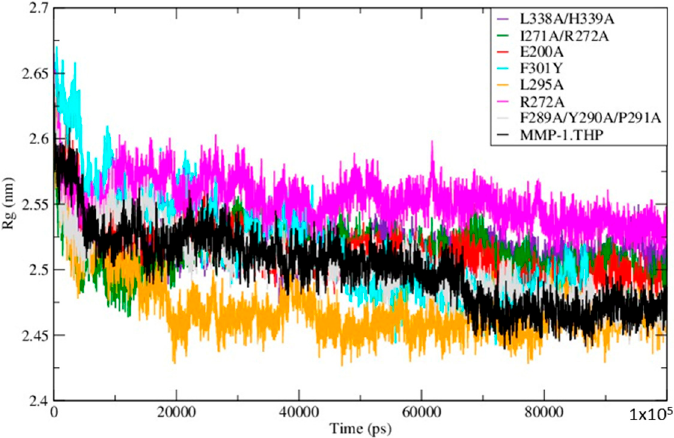
Figure 5. The radius of gyration of the mutants and WT MMP-1•THP.